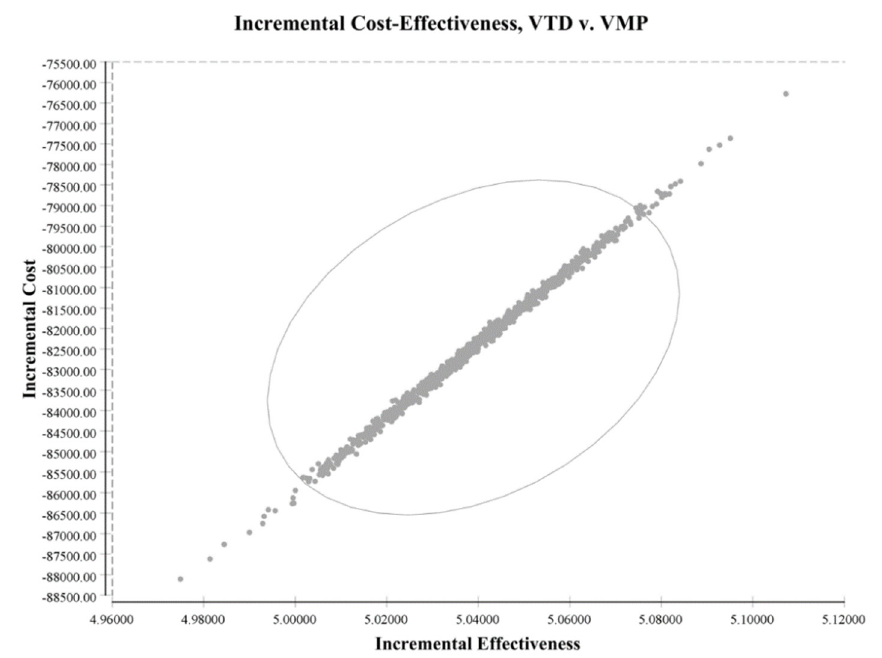
Figure 4. Scatter plot of cost and effectiveness from Monte Carlo simulation.